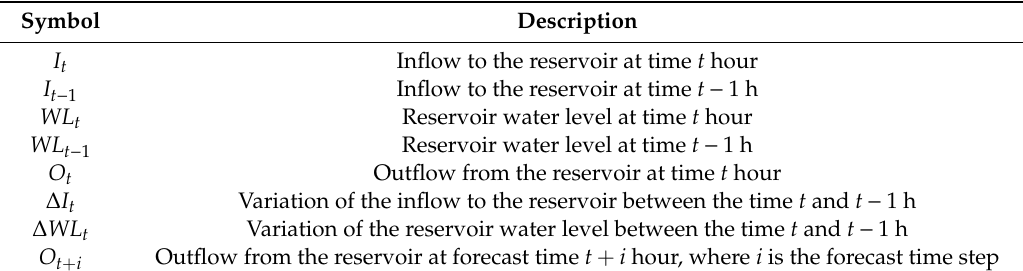
Table 3. Variables considered to build the BNet.